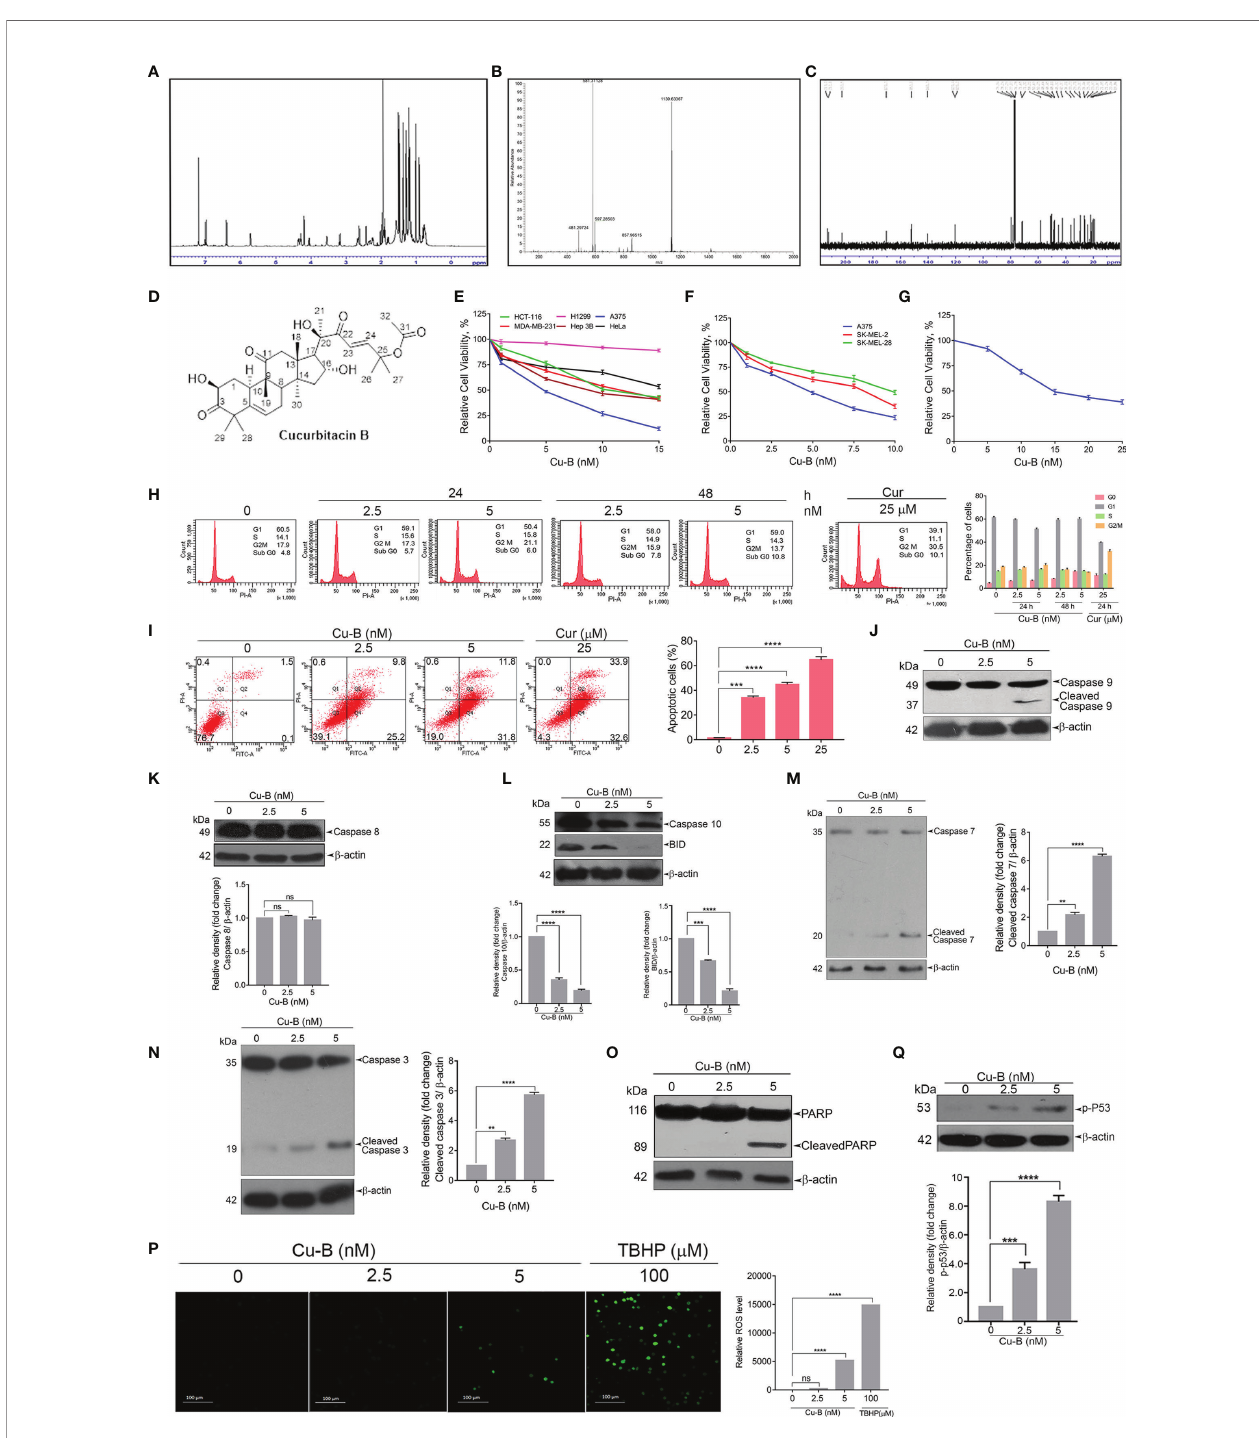
FIGURE 3 | Puri fi cation and structural elucidation of Cu-B from ECF fraction of C. epigaeus rhizome (A – D) 1 H NMR, HR-ESI-MS, 13 C NMR data, and structure of C. epigaeus -derived Cu-B. (E – G) Cytotoxicity assessment of Cu-B in melanoma cell lines and normal fi broblast cells (H) Cu-B does not affect any phases of the cell cycle in A375 cells as demonstrated by fl ow cytometry. (I) The extent of apoptosis induced by Cu-B was quantitated by Annexin V/PI FACS analysis (J – O) Cu-B treatment induces activation of caspases and cleavage of PARP in A375 cells as analyzed by immunoblotting. Cu-B promotes the cleavages of caspase-10 and Bid as analyzed by immunoblotting. (P) ROS production in response to Cu-B treatment in A375 cells as detected by fl uorescence microscopy. (Q) Cu-B potentiates p53 activation in A375 cells as analyzed by immunoblotting. Data are representative of three independent experiments (Mean±SEM) and P-values are calculated using one-way ANOVA. ****P ≤ 0.0001, ***P ≤ 0.001, **P ≤ 0.01 and ns ≥